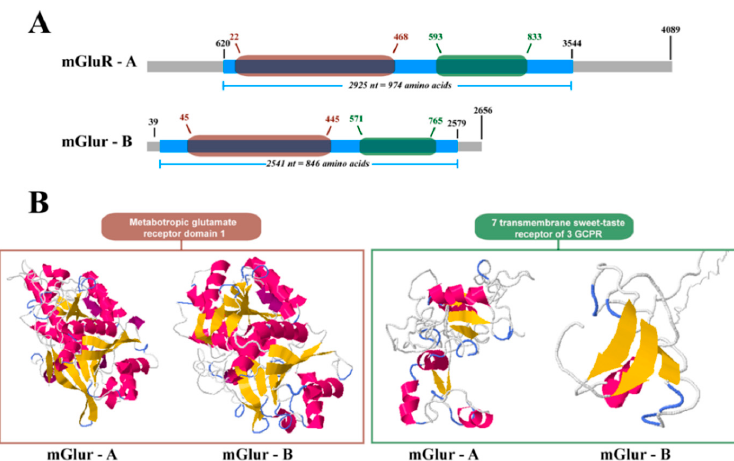
Figure 5. Structural characteristics of two metabotropic glutamate receptor (mGluR) sequences in Caligus rogercresseyi . ( A ) Sequence schemes for Cr-mGluR-A and Cr-mGluR-B, indicating the position of the open reading frame (blue rectangle), metabotropic glutamate receptor domain 1 (brown rounded-rectangle), and 7 transmembrane sweet-taste receptor of 3 GPCR (green rounded-rectangle); ( B ) Predictive model of both domains in each mGluR sequence. Brown and green lines correspond to the same domains described in A , respectively. In the models, yellow arrows correspond to beta sheets and pink regions to alpha helix.